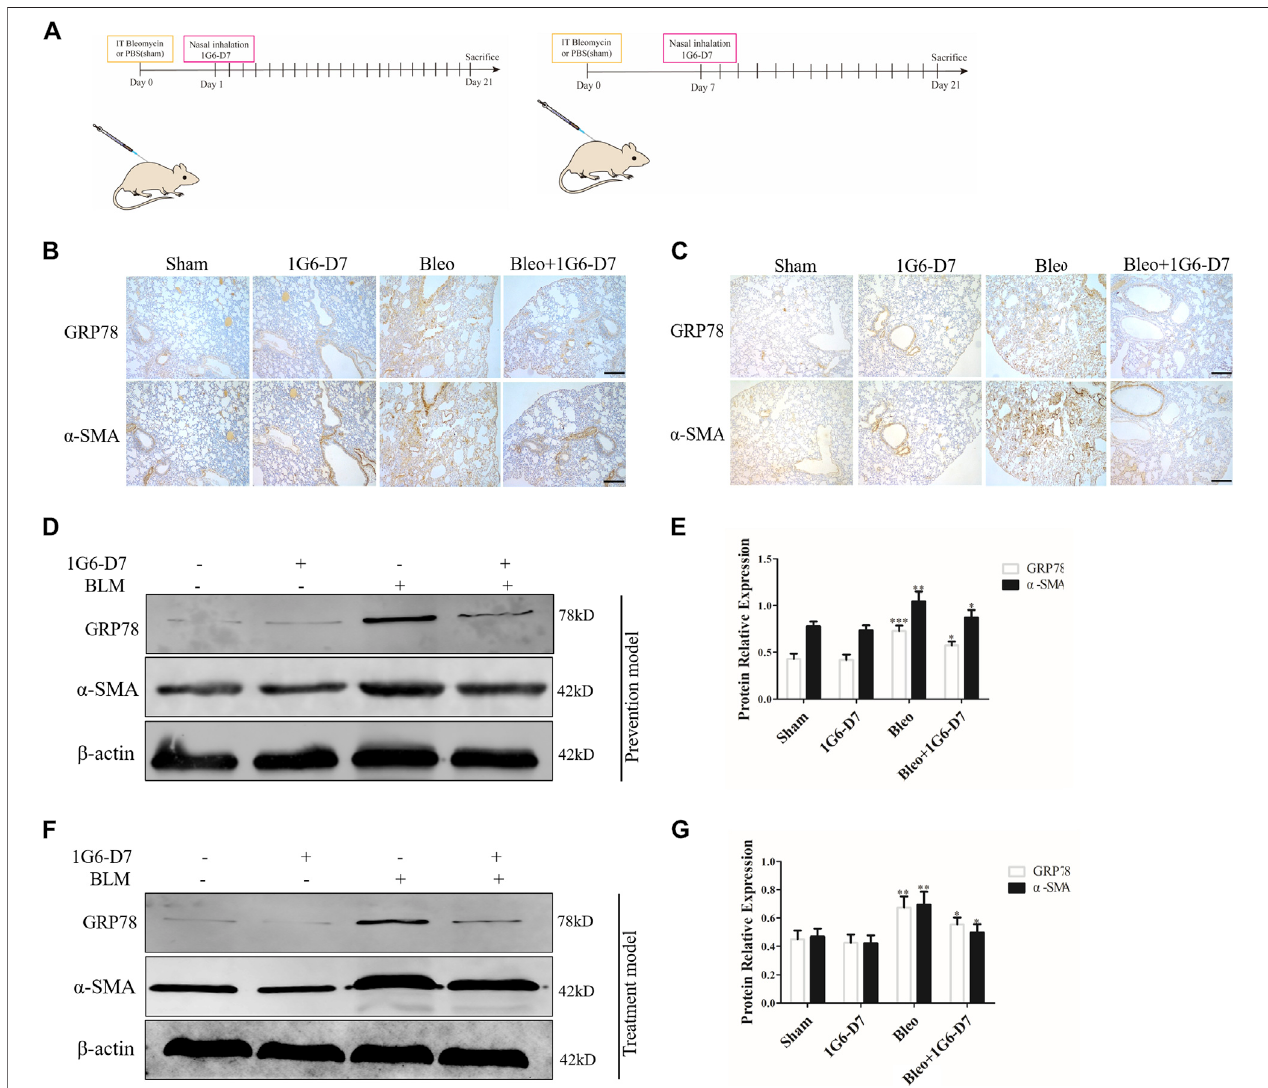
FIGURE 7 | Monoclonal antibody 1G6-D7 inhibits ER stress in the bleomycin-induced pulmonary fi brosis model. (A) . Schematic diagram of mouse model establishment ( n (cid:1) 10 for each group). (B) . Representative images showing GRP78 and α -SMA staining of lung tissues of mice in the prophylactical model. Scale bar (cid:1) 100 μ m. (C) .RepresentativeimagesshowingGRP78and α -SMAstainingoflungtissuesofmiceinthetherapeuticalmodel.Scalebar (cid:1) 100 μ m.Westernblotanalysisof theexpressionofGRP78and α -SMAintheprophylacticalmodel (D,E) andtherapeuticalmodel (F,G) . β -actinwasusedasaninternalcontrol.* p < 0.05,** p < 0.01.